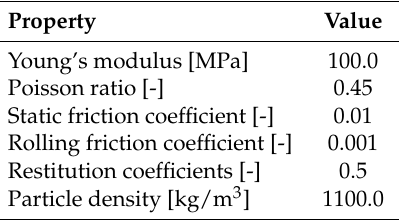
Table 2. DEM parameters